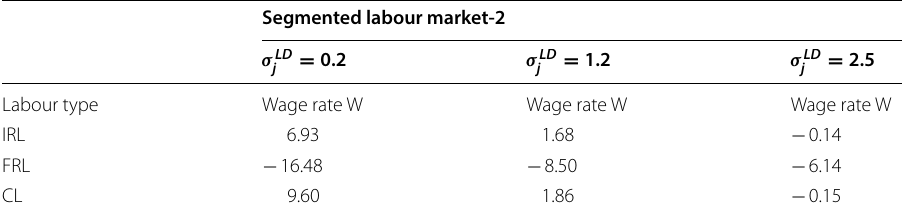
Table 12 (Scenario A3:S1–S3) Observed change (%) in economy-wide wage rates of various categories of labour due to 50% tariff cut